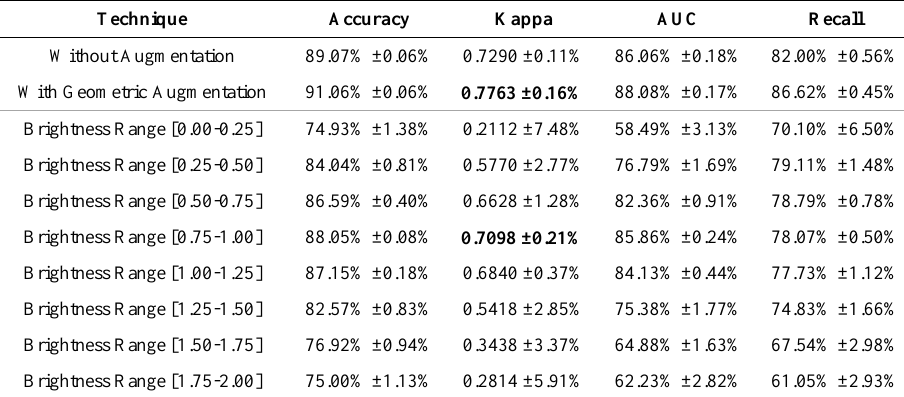
Table 4. Results of Xception network (± 95% confidence interval over repeated